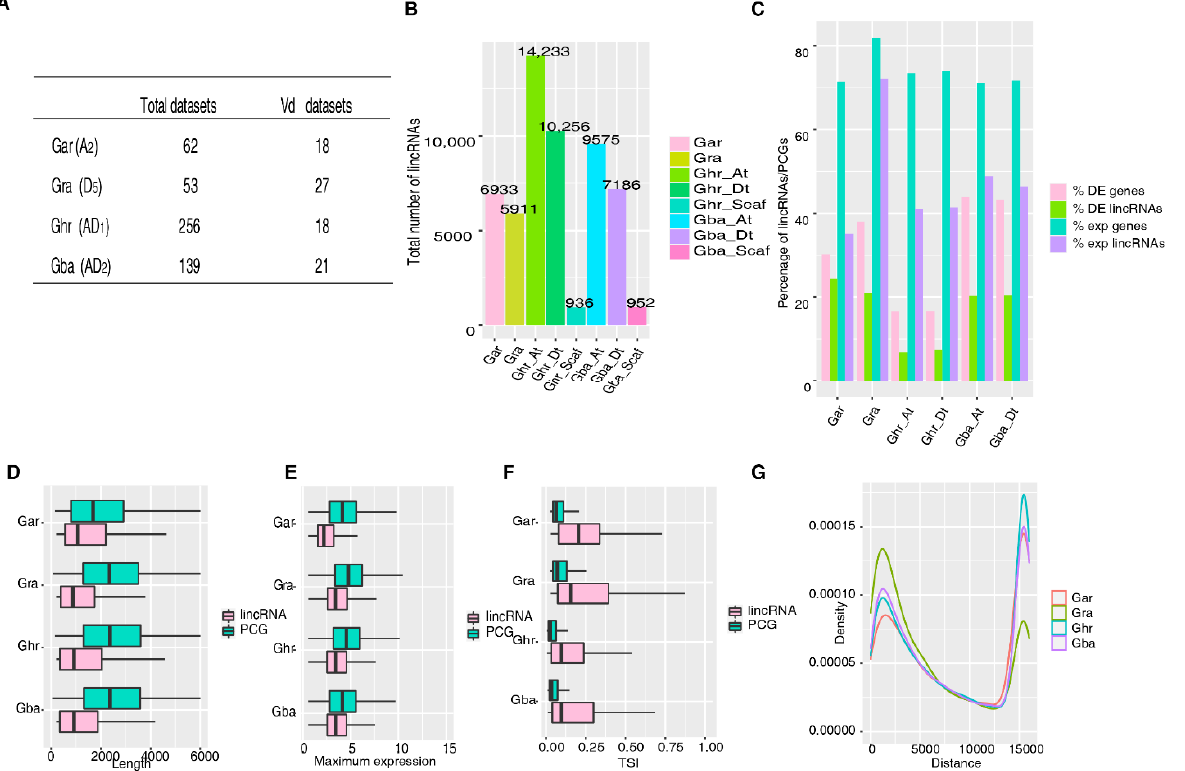
Figure 1. Features of the lincRNAs identified in diploid and allotetraploid cotton species. ( A ) The number of datasets used in identification of lincRNAs in diploid (Gar and Gra) and allotetraploid (Ghr and Gba) cotton species. Vd , Verticillium dahliae . ( B ) The number of lincRNAs identified in diploid (Gar and Gra) and the A t and D t subgenomes of the two allotetraploid cotton species (Ghr and Gba). ( C ) The percentage of the expressed protein coding genes (exp genes), the expressed lincRNAs (exp lincRNAs), the differentially expressed protein coding genes (DE genes), and the differentially expressed lincRNAs (DE lincRNAs) in the two diploids (Gar and Gra) and the A t and D t subgenomes of the two allotetraploid cotton species (Ghr and Gba). DE genes and DE lincRNAs were defined based on the datasets from Vd -infection experiments with the criteria of q-value < 0.05 and |log2(FC)| ≥ 1, using relatively highly expressed protein coding genes and lincRNAs (those with TPM < 0.5 in at least one sample were not considered). ( D ) The length of lincRNAs and protein coding genes (PCGs) in the four cotton species. ( E ) The maximum expression level (log2 transformed) of lincRNAs and PCGs in the four cotton species. ( F ) Distribution of the tissue specificity index (TSI, ranging from 0 to 1) of lincRNAs and PCGs in the four cotton species. Zero represents broadly expressed and one represents specific expression. ( G ) Distribution of the distance between lincRNAs and their nearest neighboring PCGs in the four cotton species.